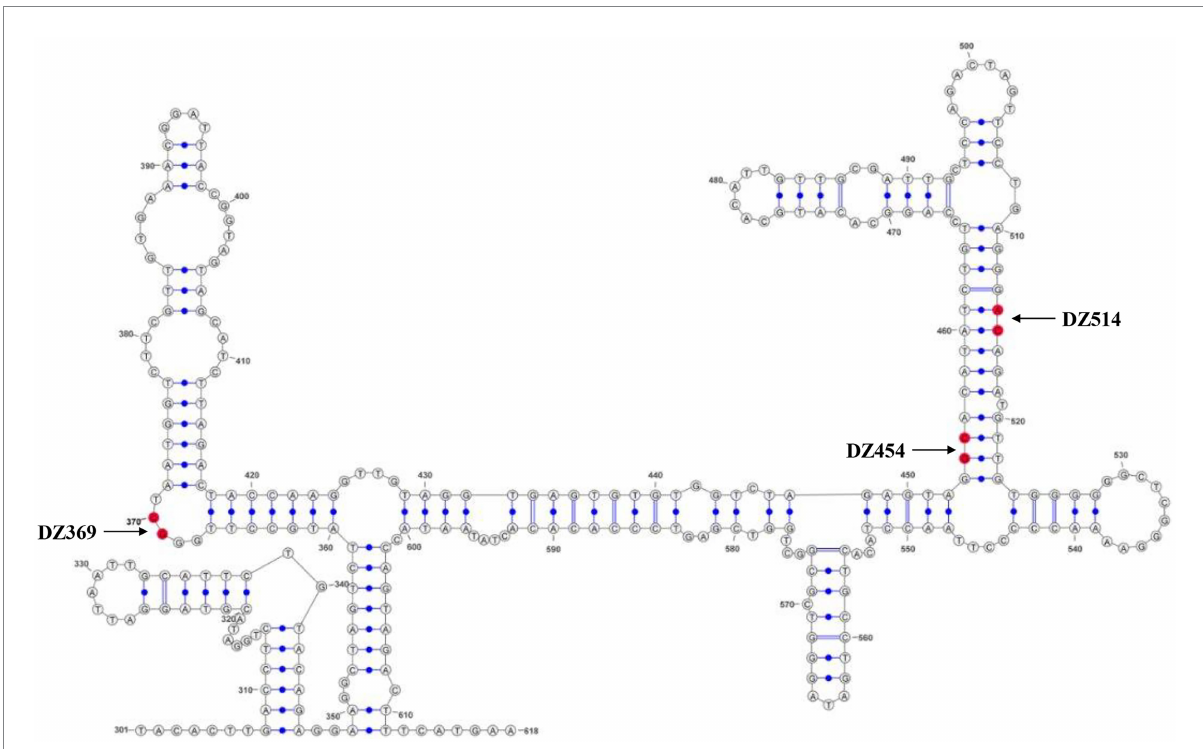
FIGURE 2 The secondary structure of the DHAV-1 5 ′ UTR 300–618 nt sequence. The bases marked in red are the potential target sites of the